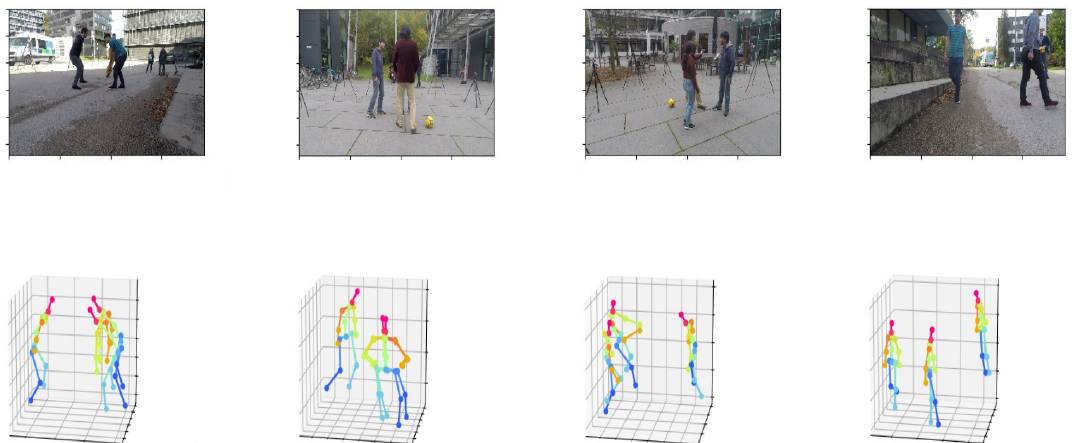
Figure 5. Erroneous 3D multi-person pose estimation. The first two images represent two similar poses of different people because one is completely occluded. In the right two images, one pose is incorrect because the body parts are partially outside of the